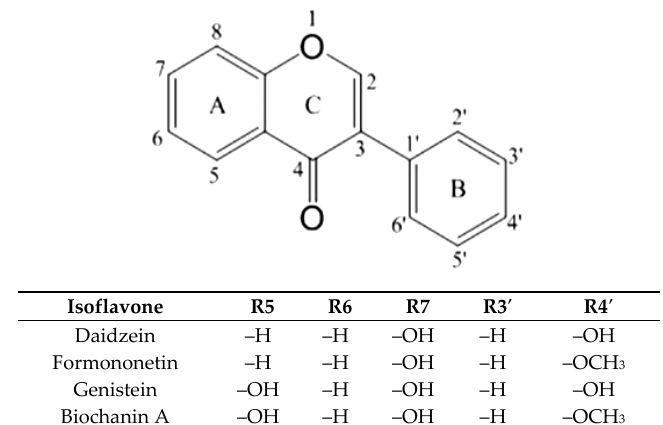
Figure 1. Structure of the main isoflavones.